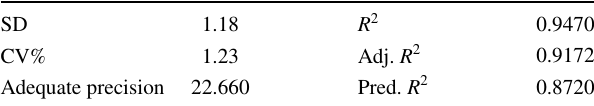
Table 4 ANOVA for response surface quadratic model for Pb(II) removal from an AESA